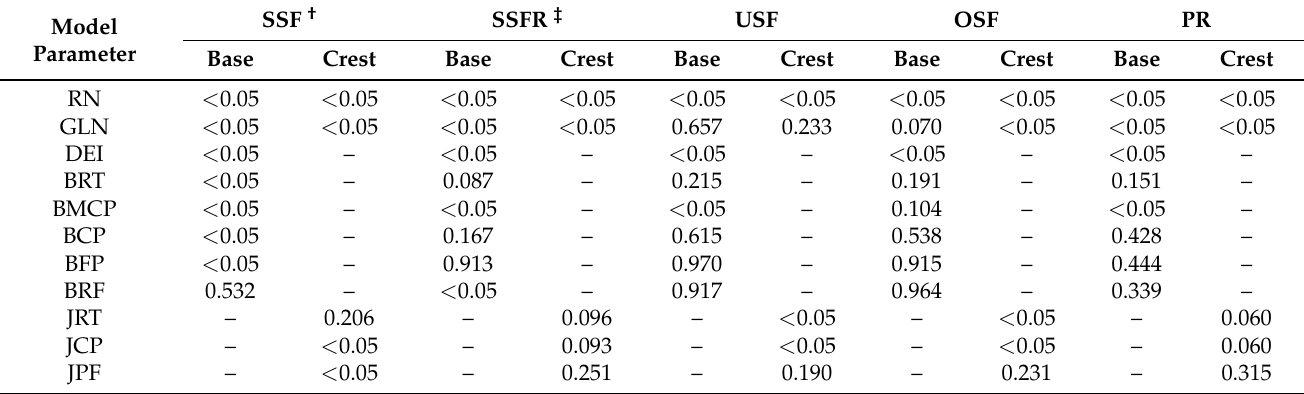
Table 6. p -values from ANOVA: summarizing the significant parameters for the base and neck sliding of the dam.